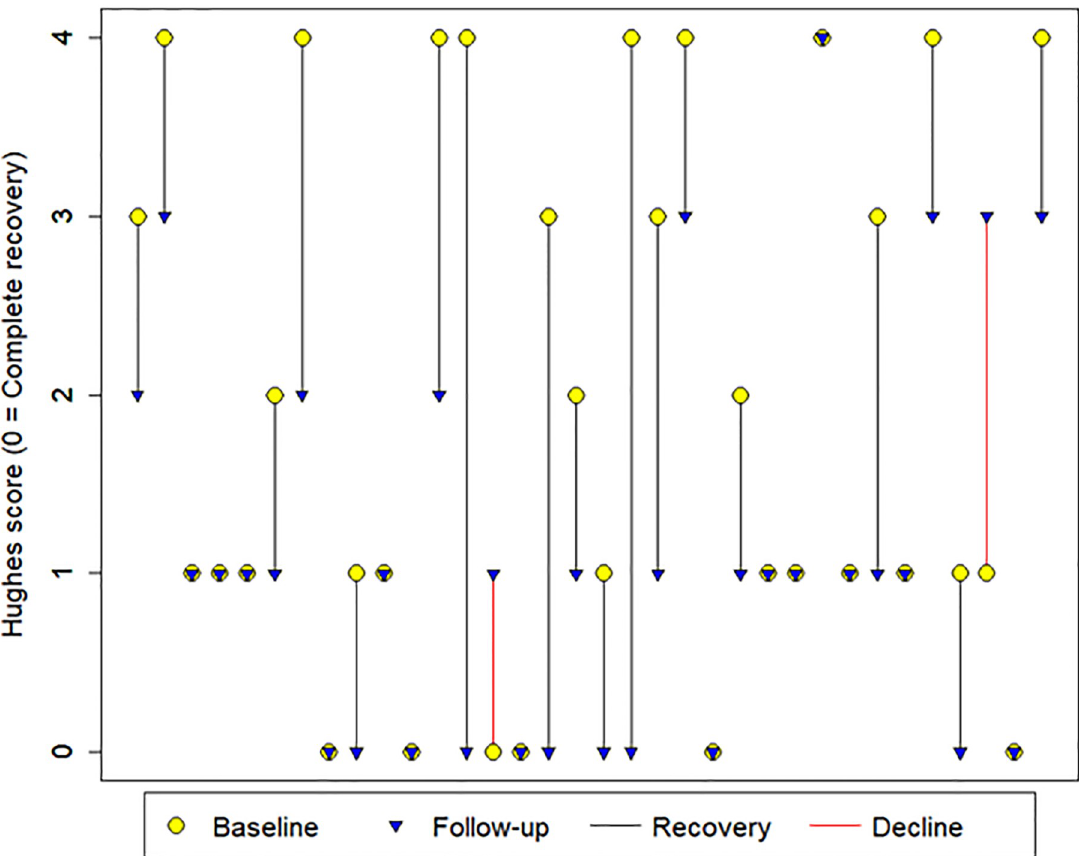
Fig 2. Comparison of Hughes score at baseline and follow-up for 34 GBS patients, Barranquilla, Colombia. The vertical lines connect each patient’s Hughes scores at baseline and follow-up. Eighteen (52%) cases had a Hughes score of 0–1 at baseline and 25 (74%) of cases had a Hughes score of 0–1 at follow-up. Eighteen of the cases had a lower Hughes score at follow-up compared to baseline, 14 had the same Hughes score, and two had a higher Hughes score at follow-up (shown in red). Hughes scores were significantly lower at follow-up (paired T test p-value: